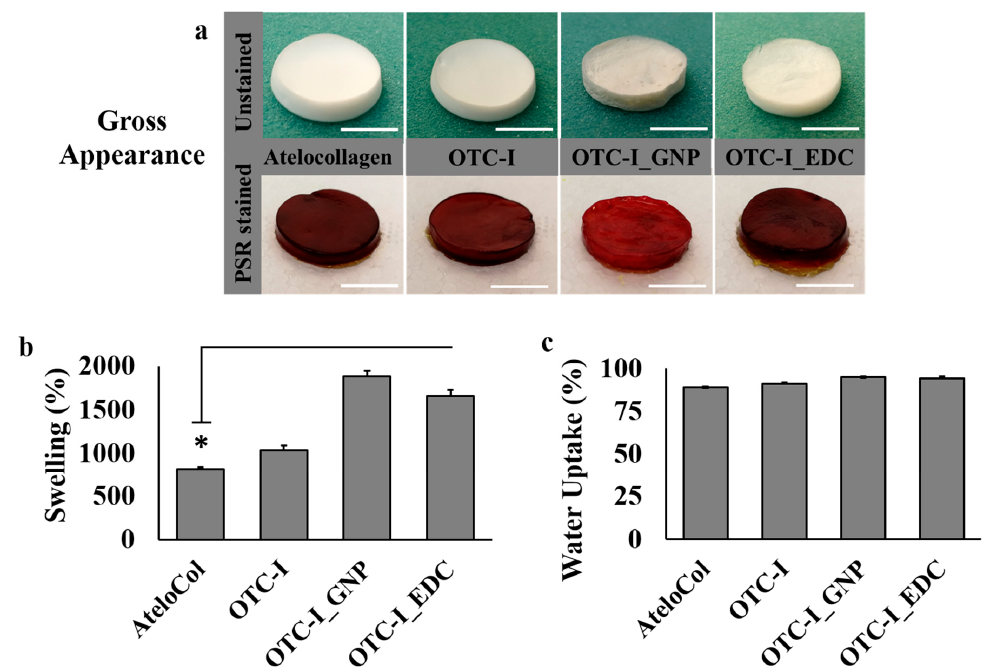
Figure 1. Gross appearance ( a ), and physical properties including the swelling ( b ) and water uptake ( c ) of the fabricated ovine collagen bioscaffold (white bar = 10 mm). * represents statistically significant difference ( p < 0.05).